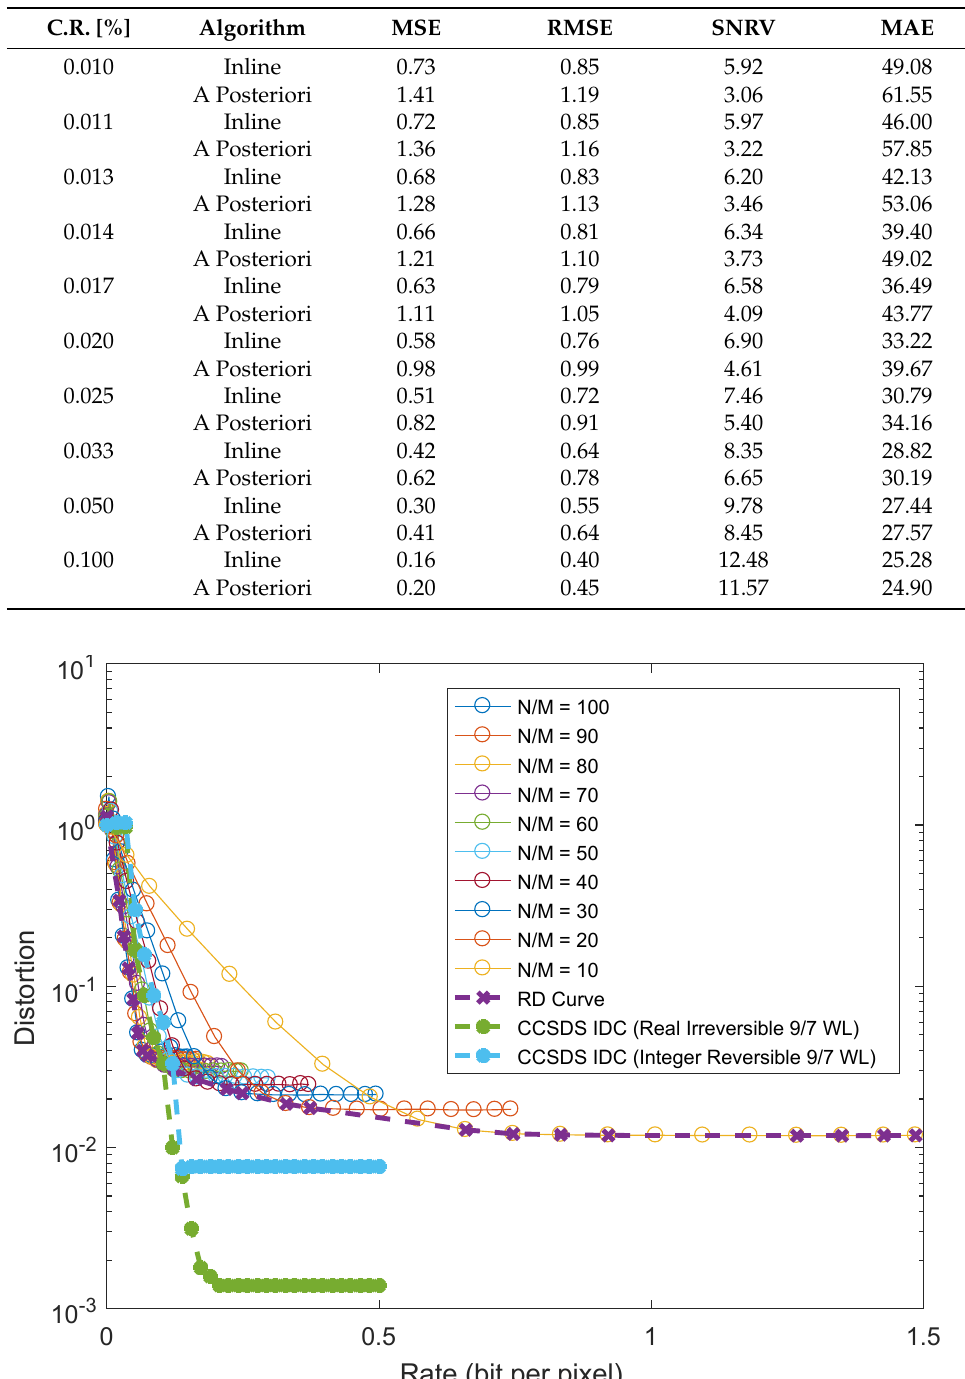
Table 4. Reconstruction results using CCSDS metrics.